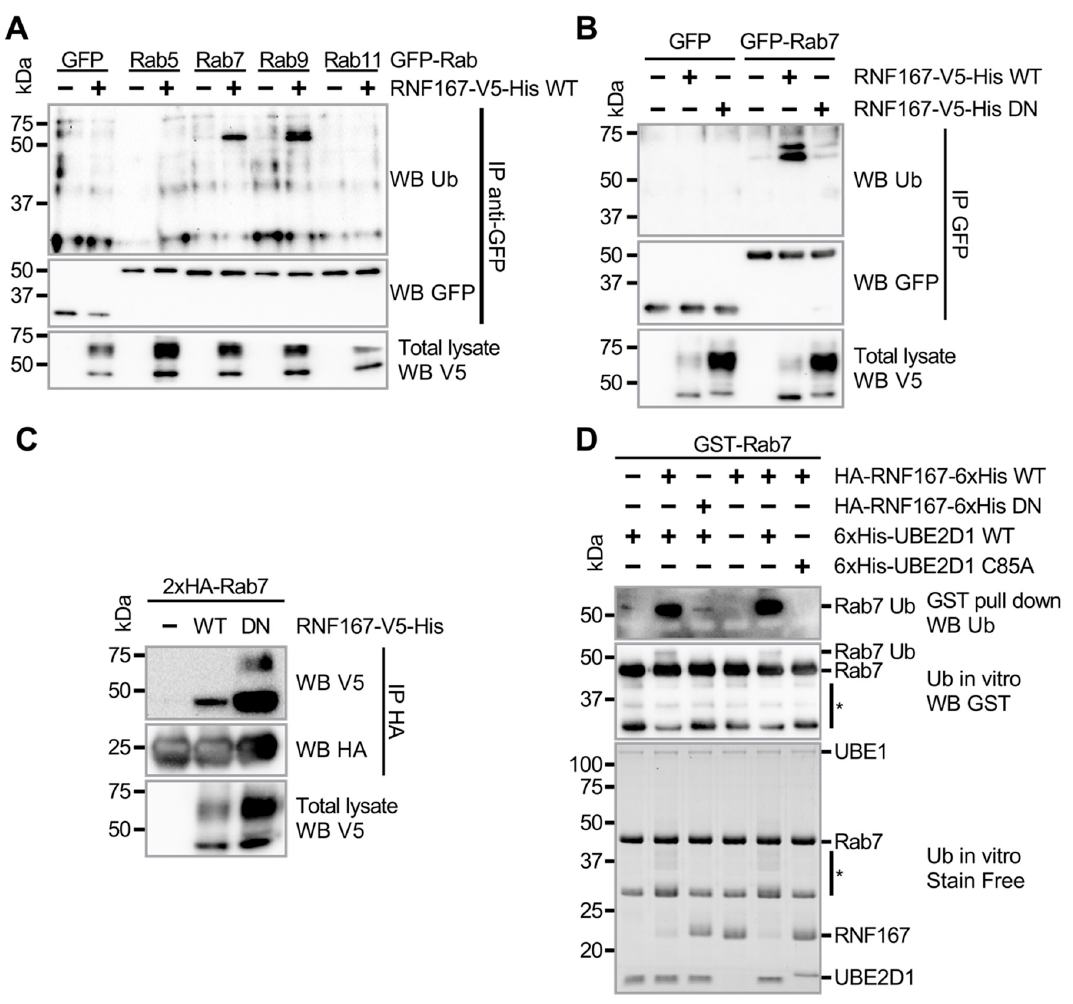
Figure 1. Rab7 protein is a substrate of RNF167 . ( A ) Late endosome-associated Rab GTPases are substrates of RNF167. HEK293T-transfected cells were lysed before immunoprecipitation with a GFP antibody. Ubiquitination of IP complexes was detected using a UB antibody. Blots are repre- sentative results of two independent experiments. ( B ) Rab7 ubiquitination in relation to RNF167 activity. HEK293T cells were transfected with respective plasmids encoding indicated proteins. Cells were lysed and immunoprecipitation was performed with a GFP antibody. Blots are repre- sentative results of two independent experiments. ( C ) When exogenously co-expressed in HEK293T cells, Rab7 co-immunoprecipitated with RNF167, either wild-type (WT) or RING variant H250W/H253W (DN). Transfected HEK293T cells were lysed in non-denaturing conditions before performing anti-HA immunoprecipitation. The presence of RNF167 in the Rab7-IP complexes was detected with a V5 antibody. Blots are representative of two independent experiments. ( D ) In vitro ubiquitination assays were performed using purified GST-Rab7, UBE1, ATP, UB, purified WT or DN HA-RNF167-6xHis, and either UBE2D1 WT or a C85A inactive variant. After incubation, the reaction was incubated with GSH resin to enrich ubiquitinated Rab7. Reactions separated on SDS- PAGE were transferred onto a PVDF membrane before immunodetection, as indicated. Representa- tive immunoblots are shown. The asterisk (*) represents a truncated GST-Rab7 protein. 2.2. RNF167 Promotes Rab7 Membrane Localization Recent studies identified three major sites of ubiquitination within the Rab7 protein [20–22]. Thus, we tested the location of RNF167-mediated Rab7 protein ubiquitination in HEK293T cells by co-transfecting plasmids encoding RNF167 with either GFP-Rab7 WT, K38R or 2KR, which combines the lysine-to-arginine substitution of both K191 and K194,